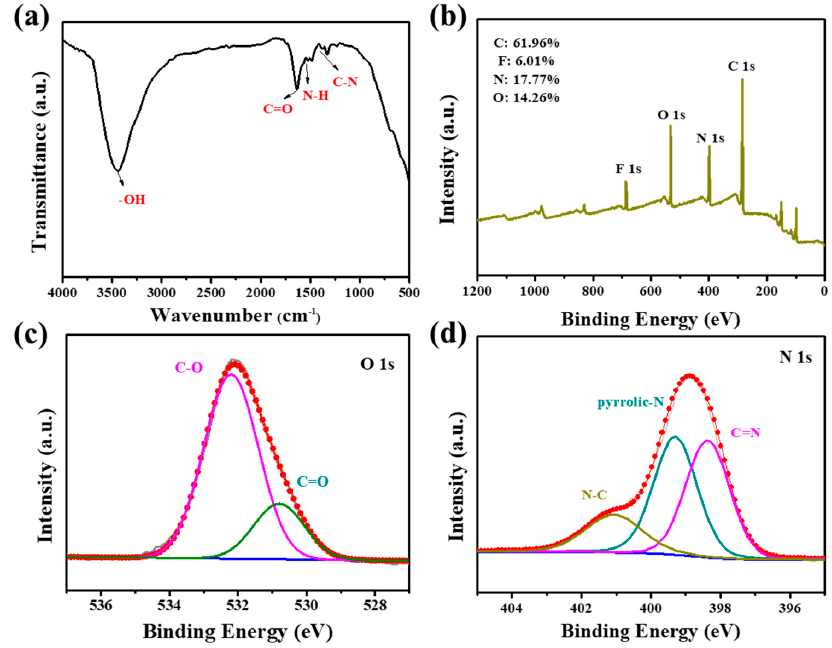
Figure 2. ( a ) FT-IR spectra and ( b ) XPS survey spectra of FNCDs. Corresponding high-resolution ( c ) O 1s and ( d ) N 1s XPS